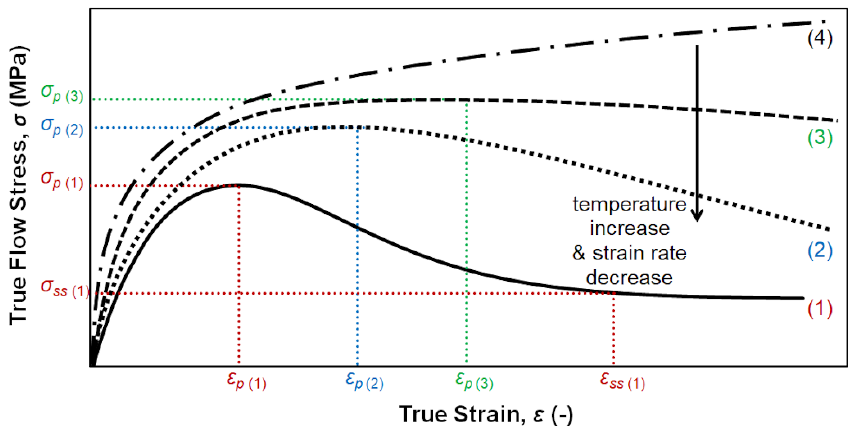
Figure 1. Influence of thermomechanical conditions on the flow stress course and position of the significant flow-curve points. The coordinates of the significant points, specifically the peak strain, peak stress, steady-state strain, and steady-state stress are labelled as ε p (-), σ p (MPa), ε ss (-) and σ ss (MPa), respectively.